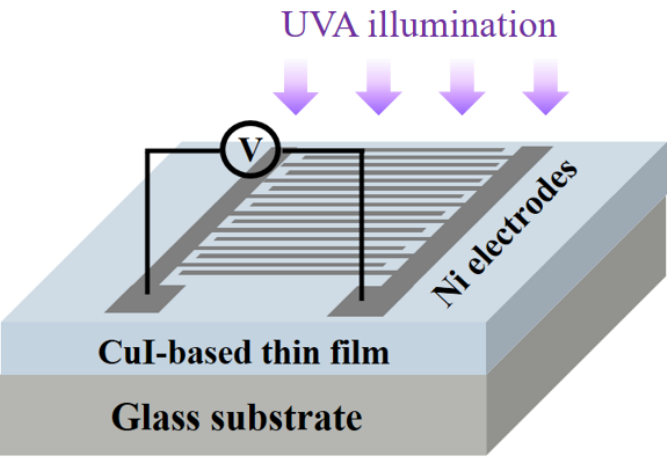
Figure 1. Schematic diagram of CuI-based MSM photodetector structure.